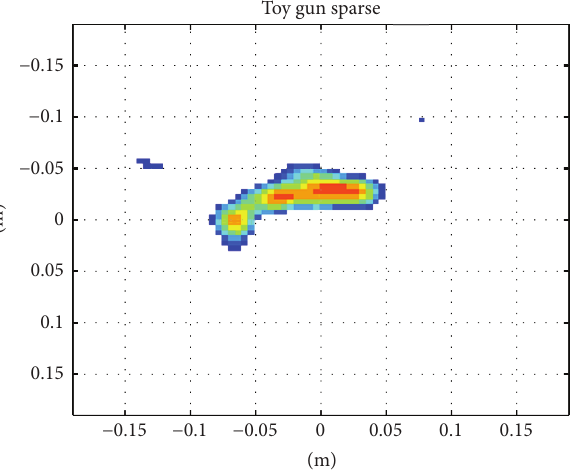
Figure 9: Sand pouch under coat (vertical).